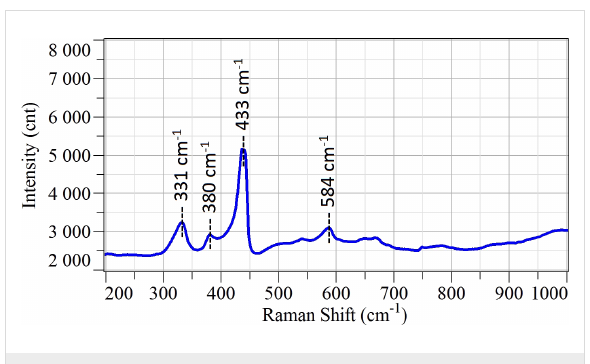
Figure 4: Raman spectrum of ZnO nanowires deposited on alumina substrates measured in ambient air at room temperature.